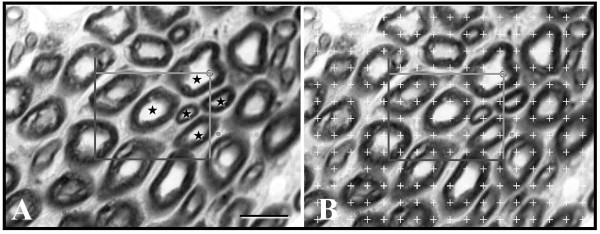
(A) A micrograph of nerve cross-section with an unbiased counting frame superimposed on it. Axons within the unbiased counting frame that are in countable position were marked with stars. Toluidine blue staining, scale bar = 10 μm. (B) The same micrograph with the point counting grid superimposed on it. If an axon is crossed with the right corner of the unbiased counting frame during systematic random sampling, cross section areas of this axon was estimated by means of counting the test points of grid coincide into the axon.